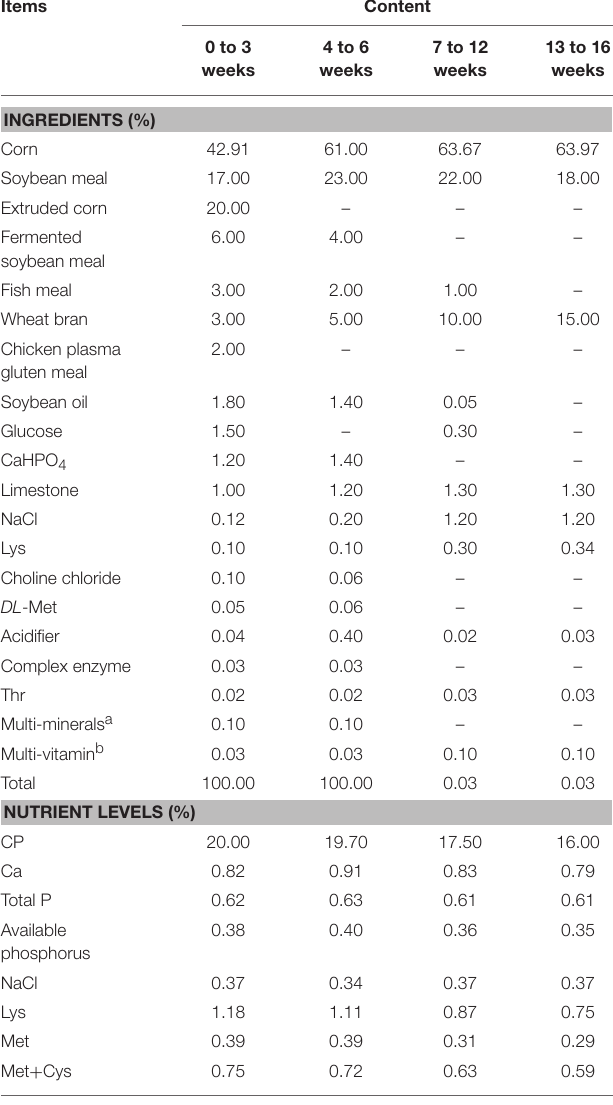
TABLE 1 | Composition and nutrient levels of basal diets (as-fed basis).